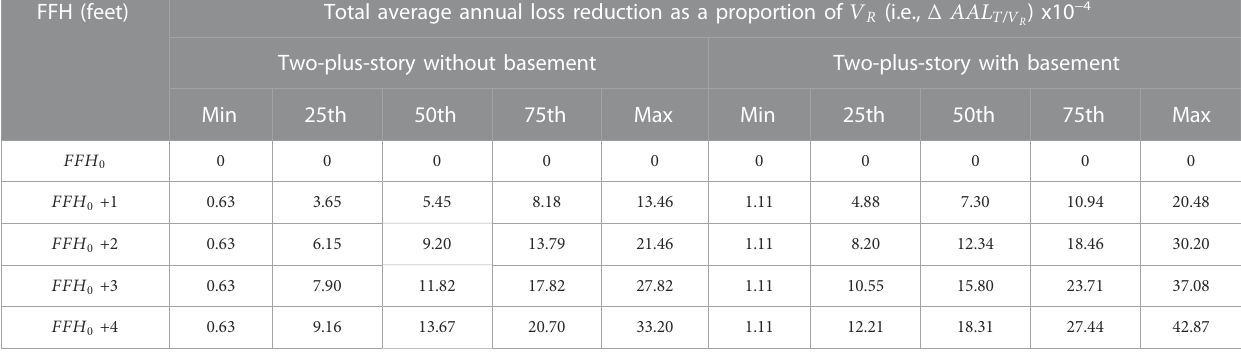
TABLE 8 Annual fl ood risk reduction by FFH elevation for two-plus-story single-family home with and without basement using synthetic data. FFH (feet)